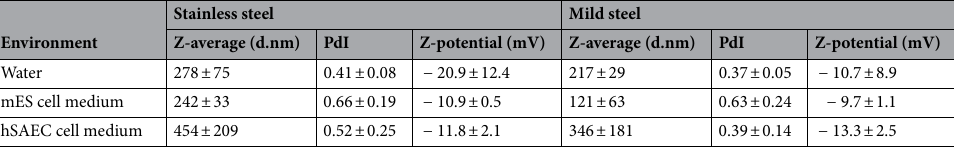
Table 1. Particle characterization by dynamic light scatering (DLS) in water and cell culture media directly after preparation of 50 µg/mL dispersions. Data is presented as mean ± SD. PdI, polydispersity index; mES, mouse embryonic stem cells; hSAEC, human small air epithelial cells.